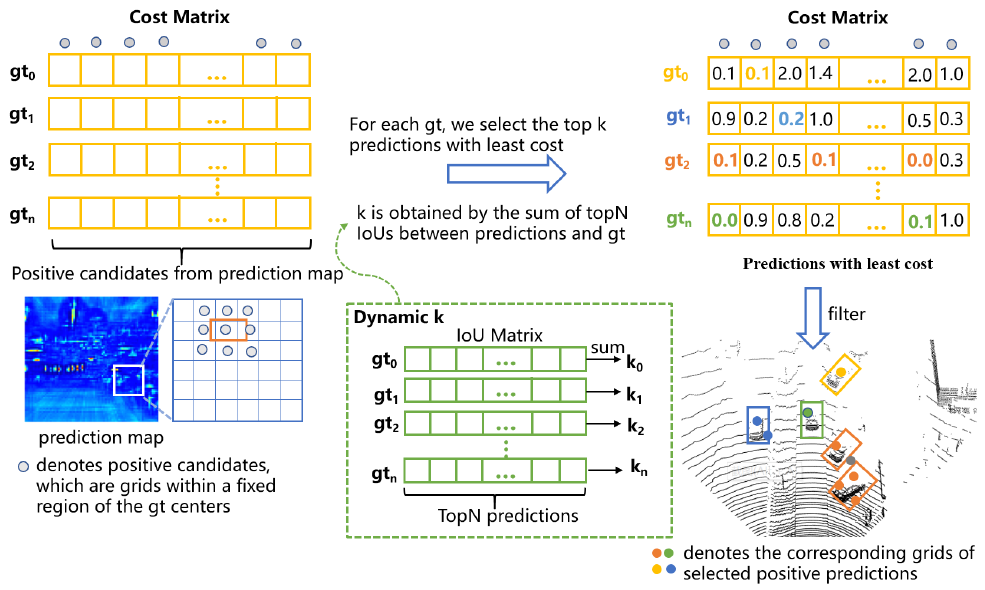
Figure 5. Optimal transport assignment in 3D object